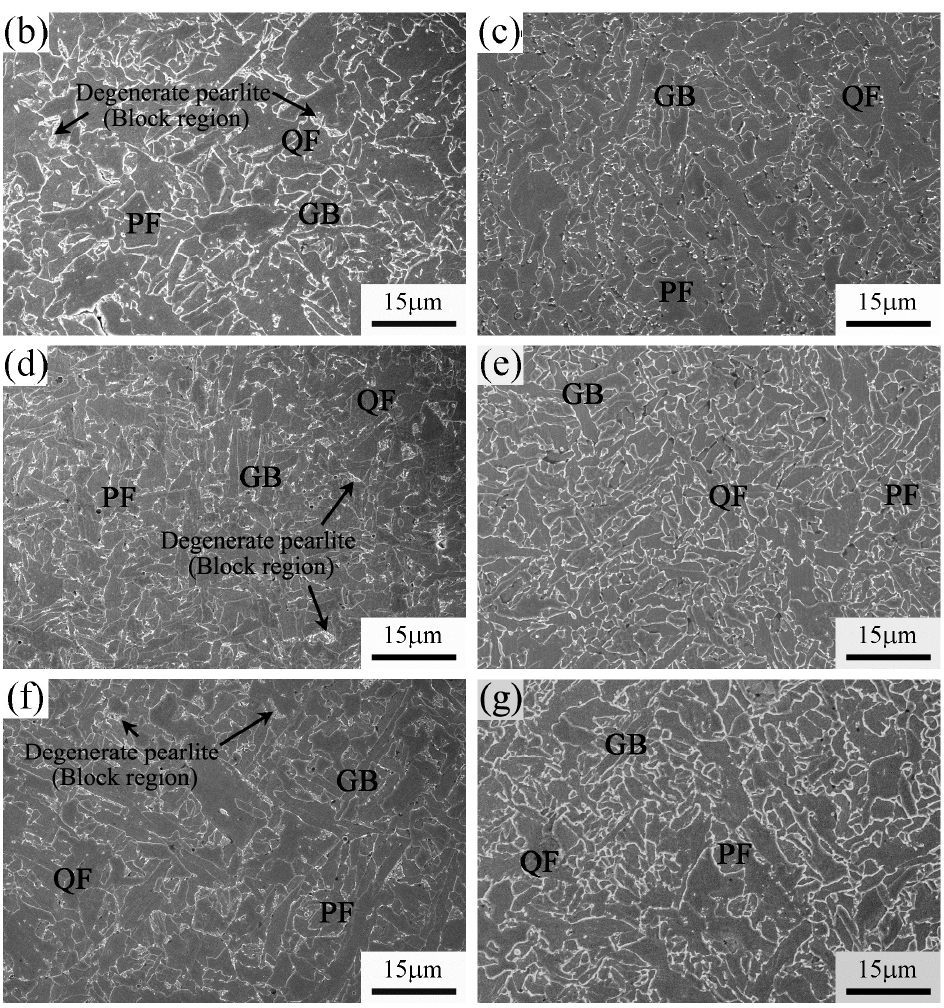
Figure 4. SEM micrograph for specimens treated under different conditions: ( a ) Prior to treatments; ( b ) RT = 990 °C, TT = 550 °C; ( c ) RT = 990 °C, TT = 680 °C; ( d ) RT = 1030 °C, TT = 550 °C; ( e ) RT = 1030 °C, TT = 680 °C; ( f ) RT = 1080 °C; TT = 550 °C; ( g ) RT = 1080 °C, TT = 680 °C. (RT: reheating temperature; TT: tempering temperature).